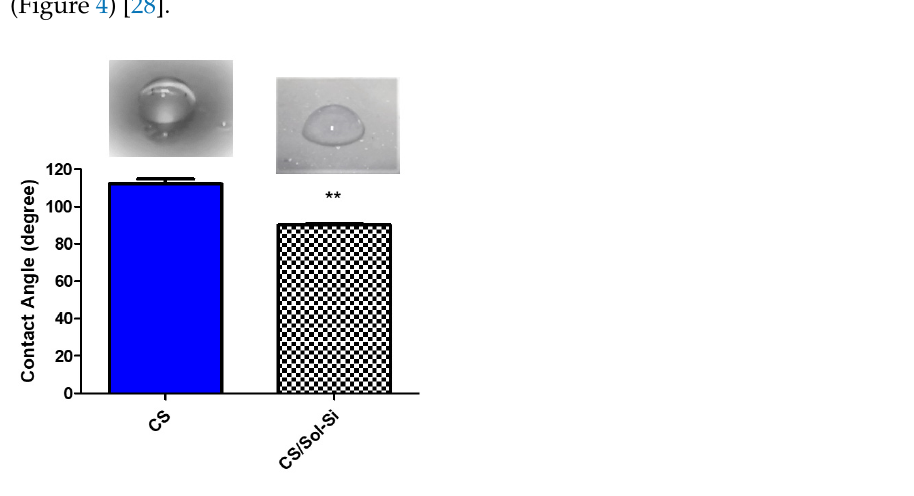
Figure 4. Contact angle of CS and CS/Si-Sol biocomposite. ** ( p < 0.0001) according to Student’s t -test.